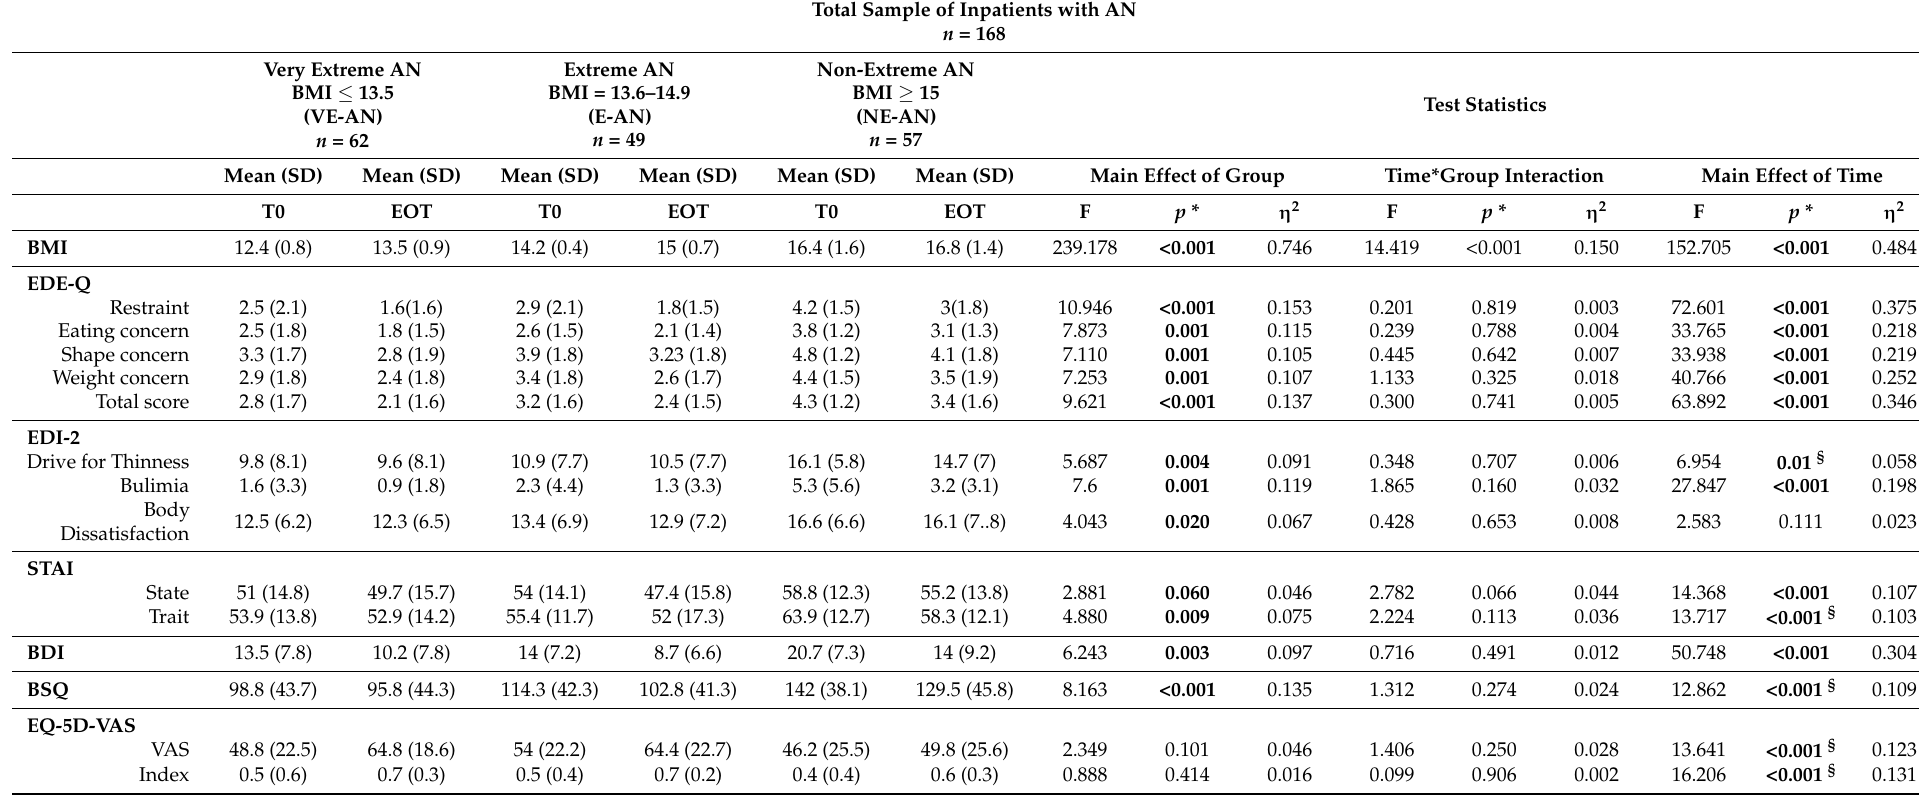
Table 3. Clinical outcome of hospitalization across groups with different body mass index severity.